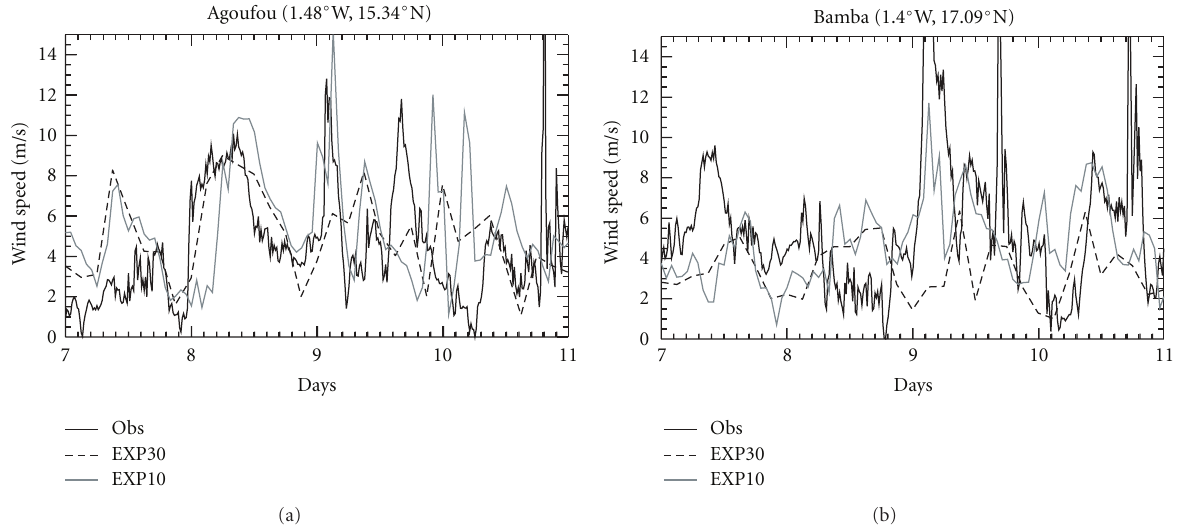
Figure 10: Time series of WRF-Chem-simulated and observed wind speed at 10m height. Observations (black solid curve), EXP30 30 km (grey solid curve) and EXP10 10km (grey dotted curve).